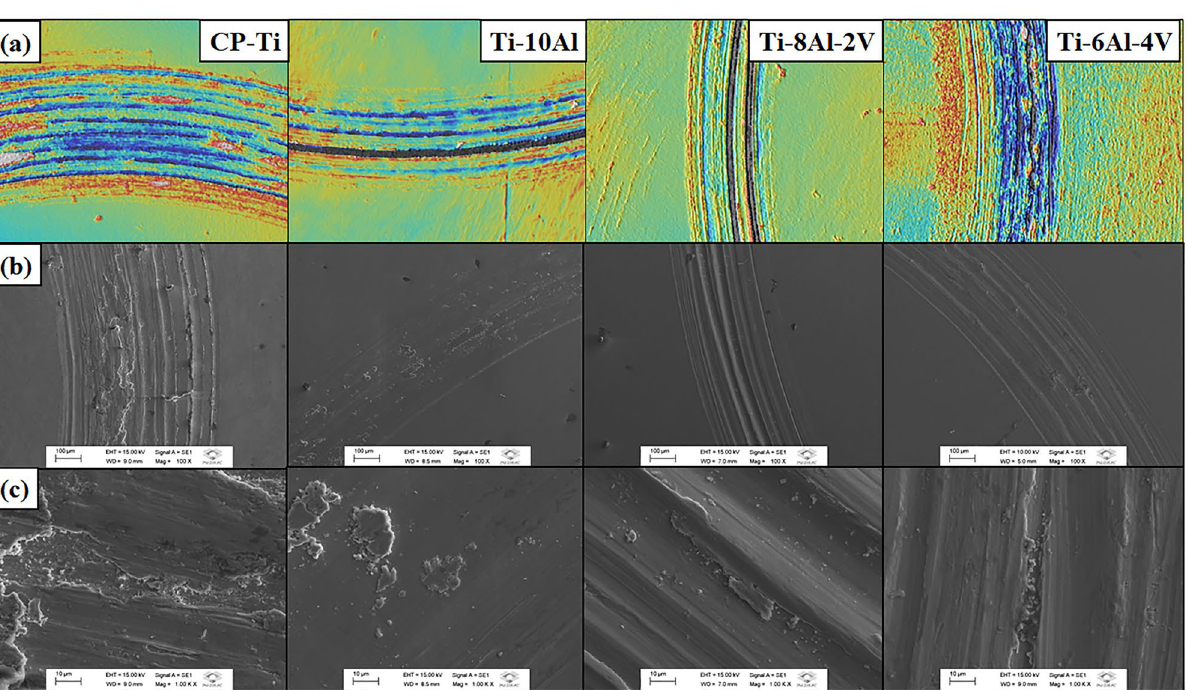
Figure 9. Topography of the wear tracks: ( a ) confocal 3D laser imaging at 10x and SE-SEM imaging at ( b ) 100x and (c)